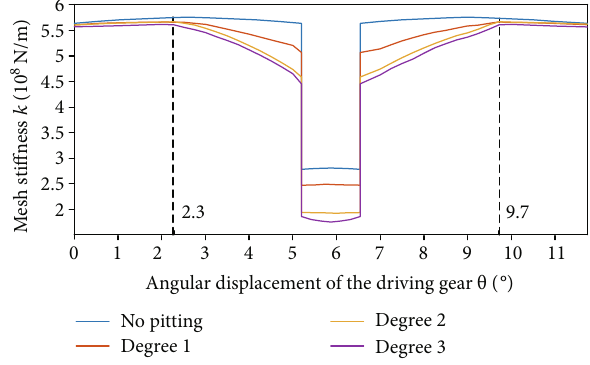
Figure 4: Meshing sti ff ness of pitting gear with di ff erent degrees. Table 2: Mesh sti ff ness drop